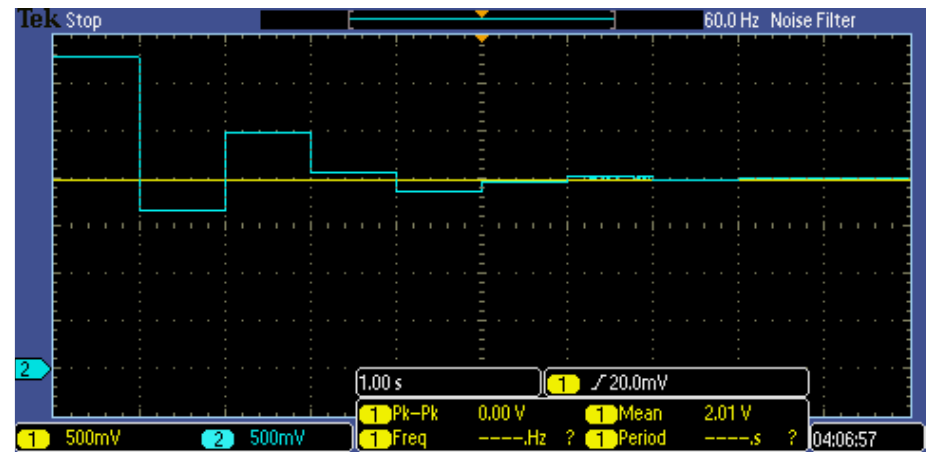
Figure 14. Measurement result of AOCL.